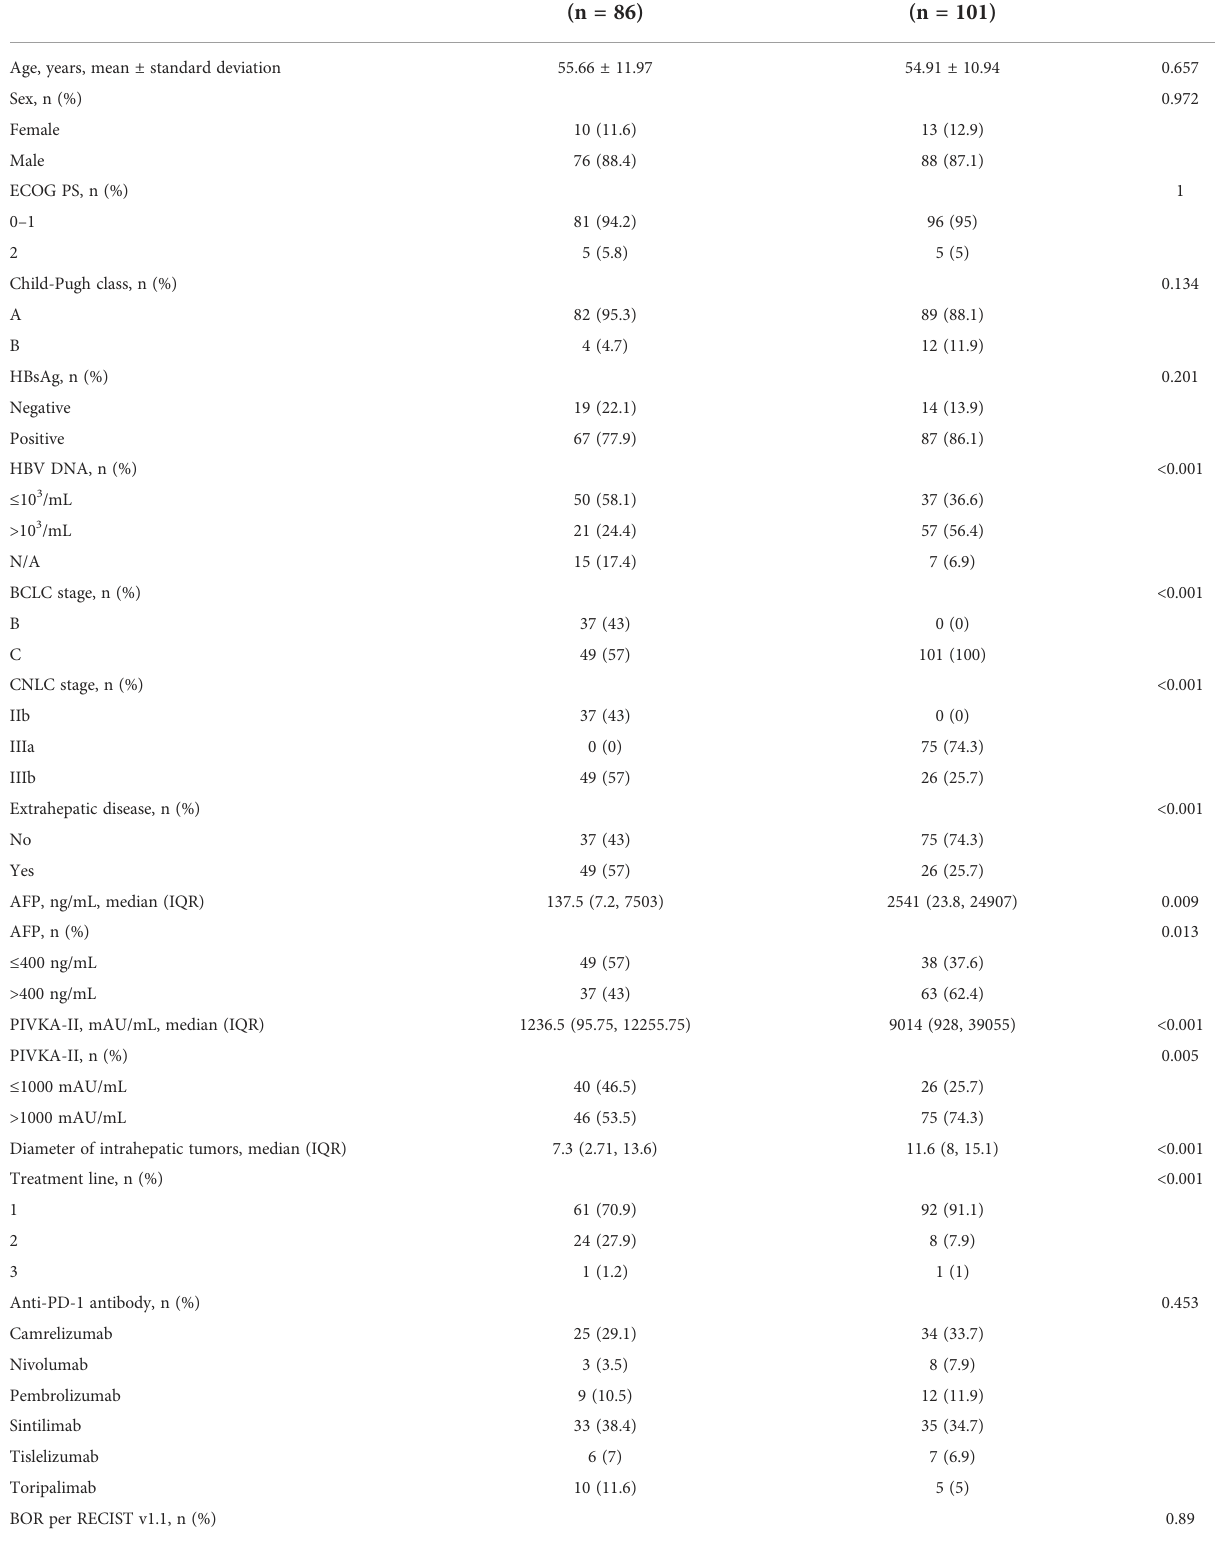
TABLE 2 Clinicopathologic features and response in patients with or without macrovascular